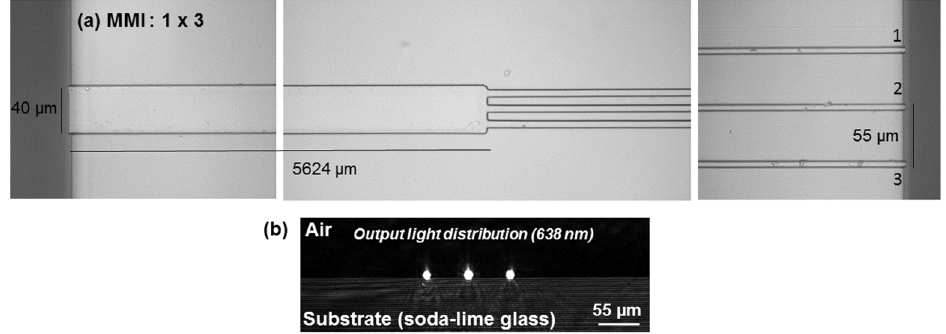
Figure 9. ( a ) Microscopic observation of a 1 × 3 MMI coupler obtained by micro-structuration of a TiO 2 –SiO 2 layer. ( b ) Output light intensity distribution under excitation at 638 nm.